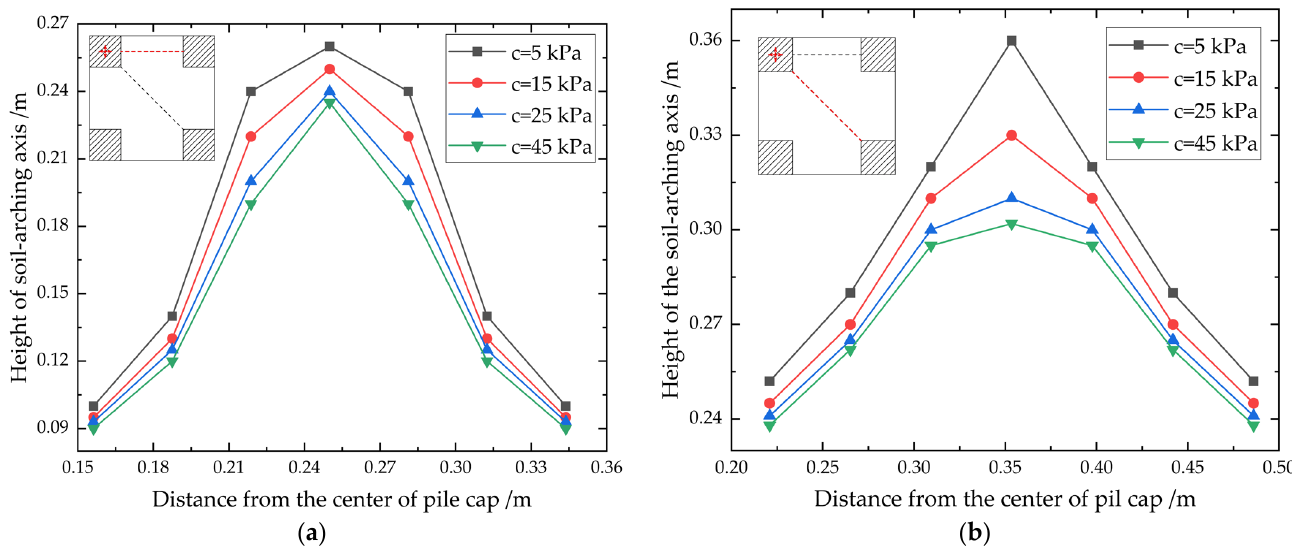
Figure 12. The soil-arching axis in the embankment, ( a ) the soil-arching crown between the hori- Figure 14. Schematic diagram of area division in the embankment. ( a ) Low embankment height, zontal adjacent piles; ( b ) the soil-arching crown between the diagonal adjacent piles. ( b ) High embankment